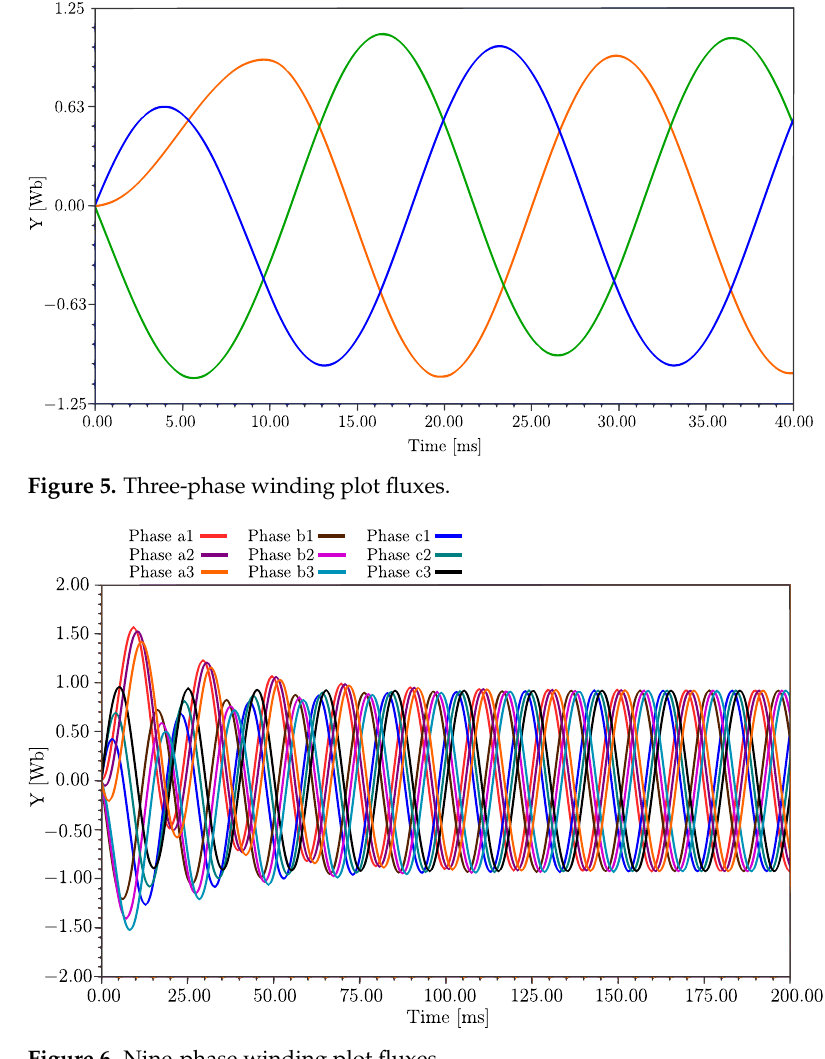
Figure 6. Nine-phase winding plot